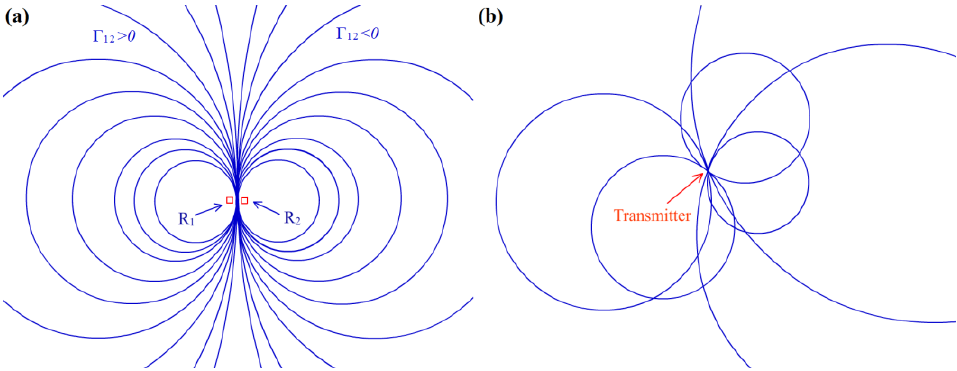
Figure 1. ( a ) Associated circles corresponding to the RSS differences Γ 12 . The receivers are located at R 1 and R 2 ; ( b ) Transmitter at the intersection of 6 associated circles, assuming Equation (2) is perfectly followed.